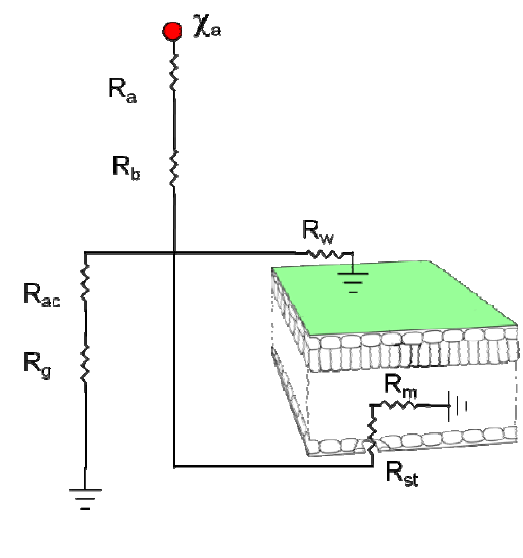
Figure 1. Schematic of dry deposition model for soil and